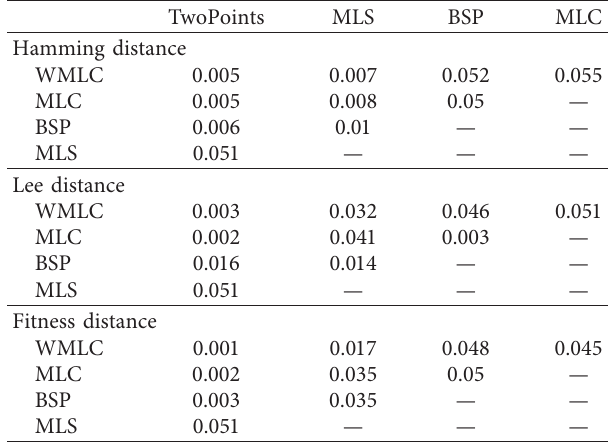
Table 2: Adjusted P values for every pair of heuristics in course timetabling